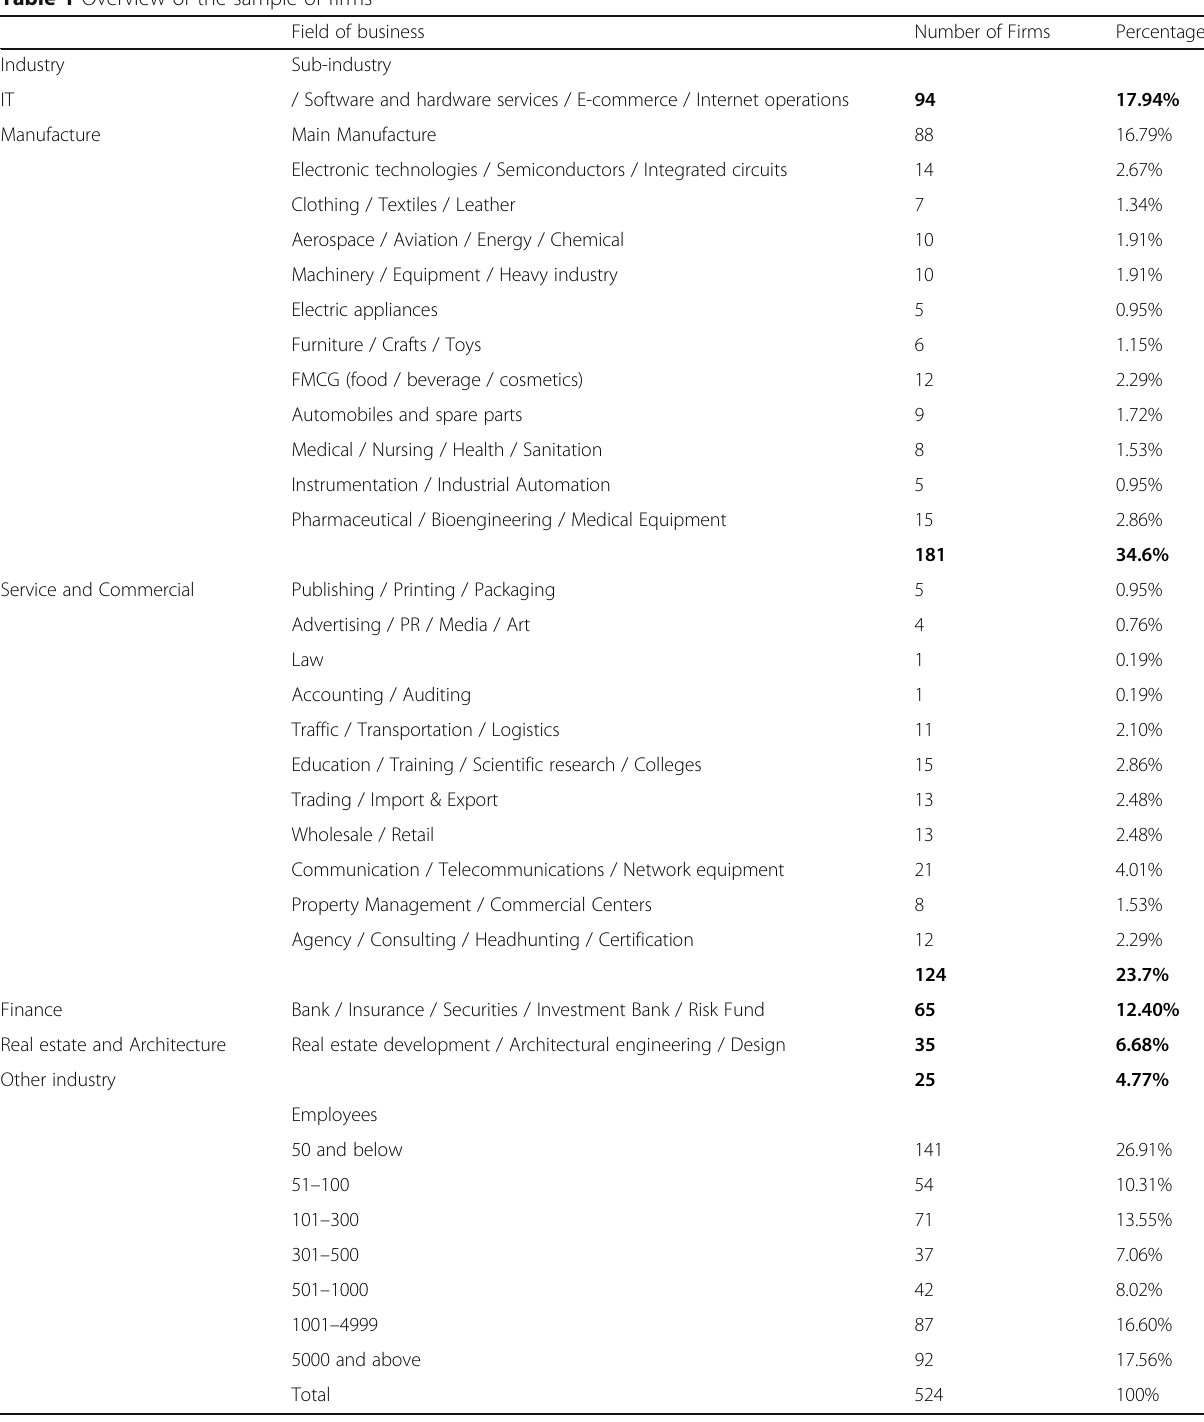
Table 1 Overview of the sample of